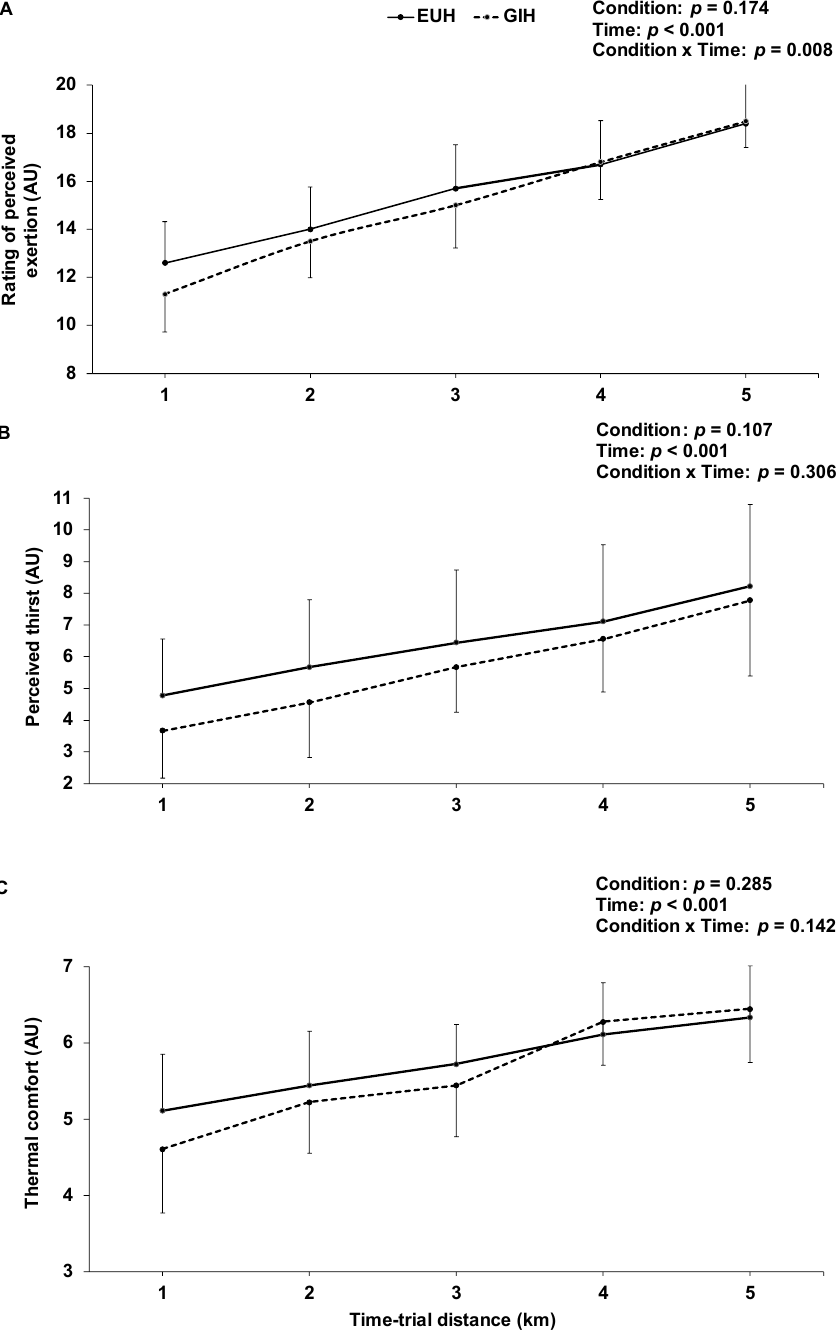
Figure 5. Effects of EUH and GIH on the rating of perceived exertion ( A ), perceived thirst ( B ) and thermal comfort ( C ) during the time-trials. AU = arbitrary units; EUH = euhydrated; GIH = glycerol- induced hyperhydration.